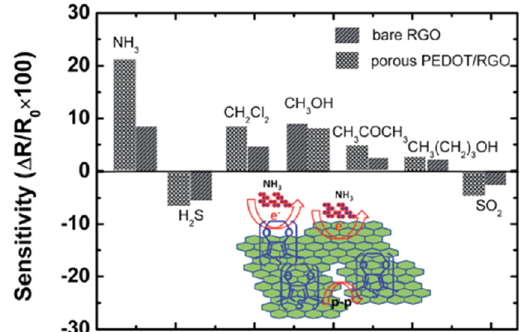
Figure 30: Gas selectivity of bare rGO and PEDOT/rGO - based sen - sing device towards 1 ppm various analyte gases. Reproduced from ref. [ 192 ] .